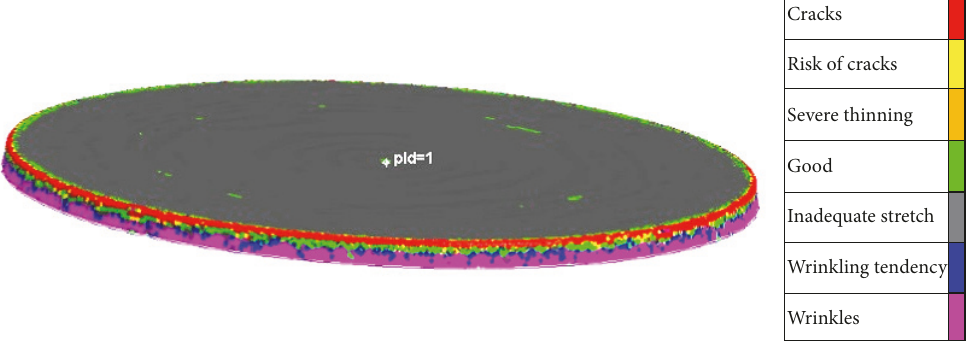
Figure 10: Cracks and wrinkles by press forming.